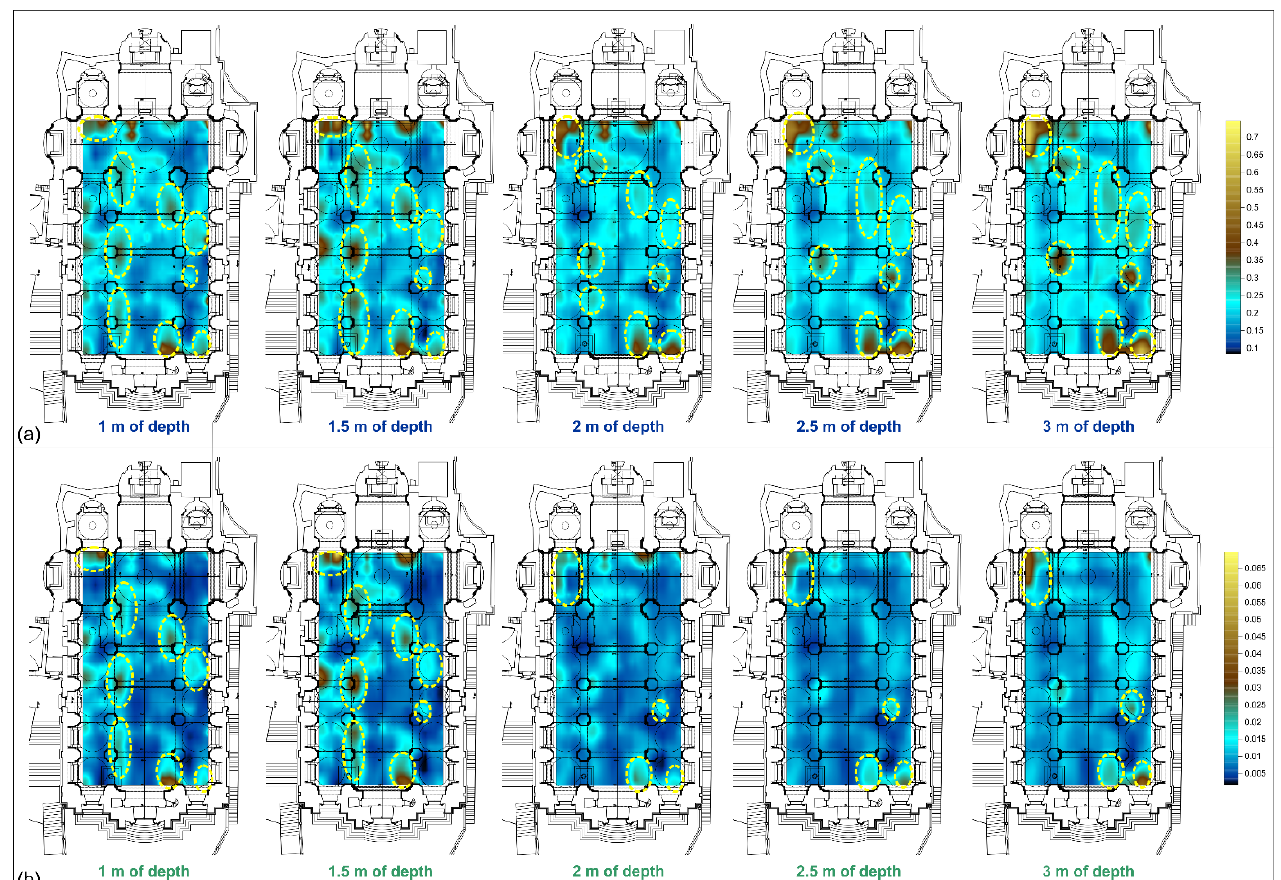
Figure 12. Maps of anomalies between 1 and 3 m of depth obtained from the sum ( a ) and product ( b ) between passive seismic and seismic tomography data. The yellow dashed circles highlighting the anomalies identified in the maps.